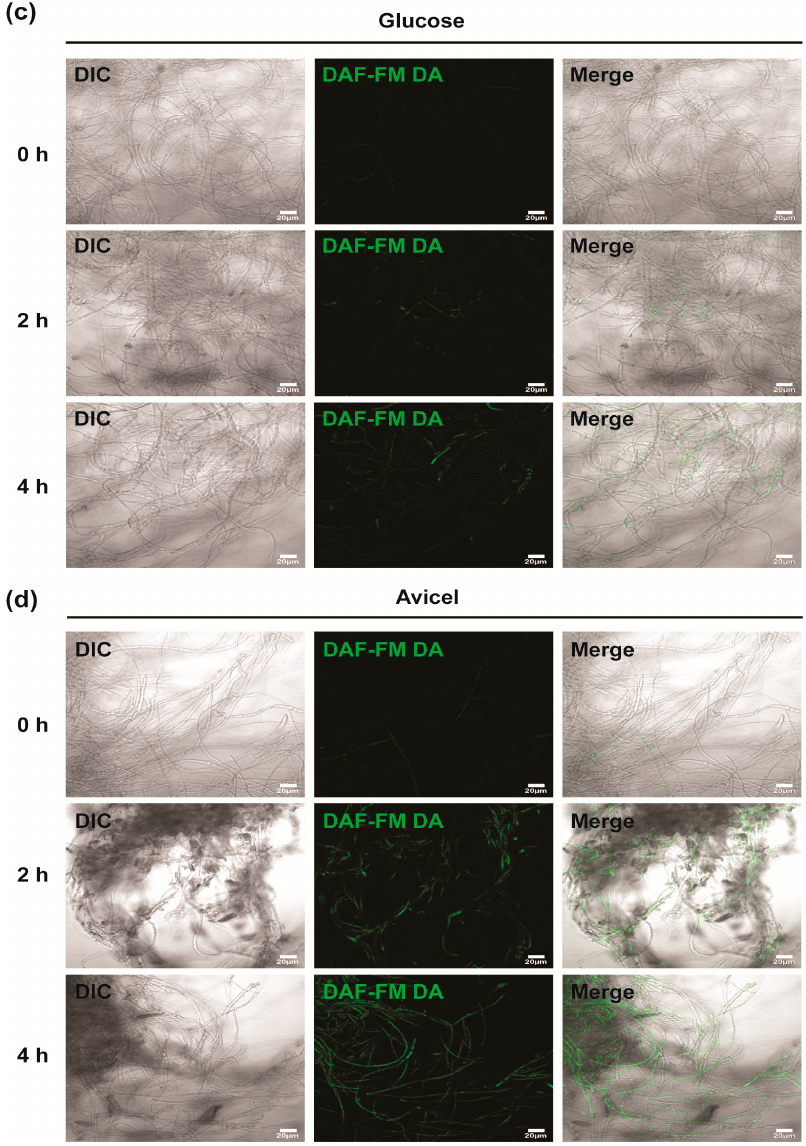
Figure 4. Analysis of intracellular ROS and NO in Neurospora crassa hyphae grown for 0, 2 and 4 h. Intracellular ROS was detected using H 2 DCF-DA (green fluorescence) in fungal hyphae grown in glucose ( a ) or Avicel ( b ) medium. Intracellular NO was detected using DAF-FM DA (green fluorescence) in fungal hyphae grown in glucose ( c ) or Avicel ( d ) medium. DIC: differential interference contrast, H 2 DCF-DA or DAF-FM DA: fluorescence, Merge: combined image of DIC and fluorescence. 2.4. Intracellular NO Is Involved in the Regulation of Cellulolytic Enzyme Production in Avicel Medium